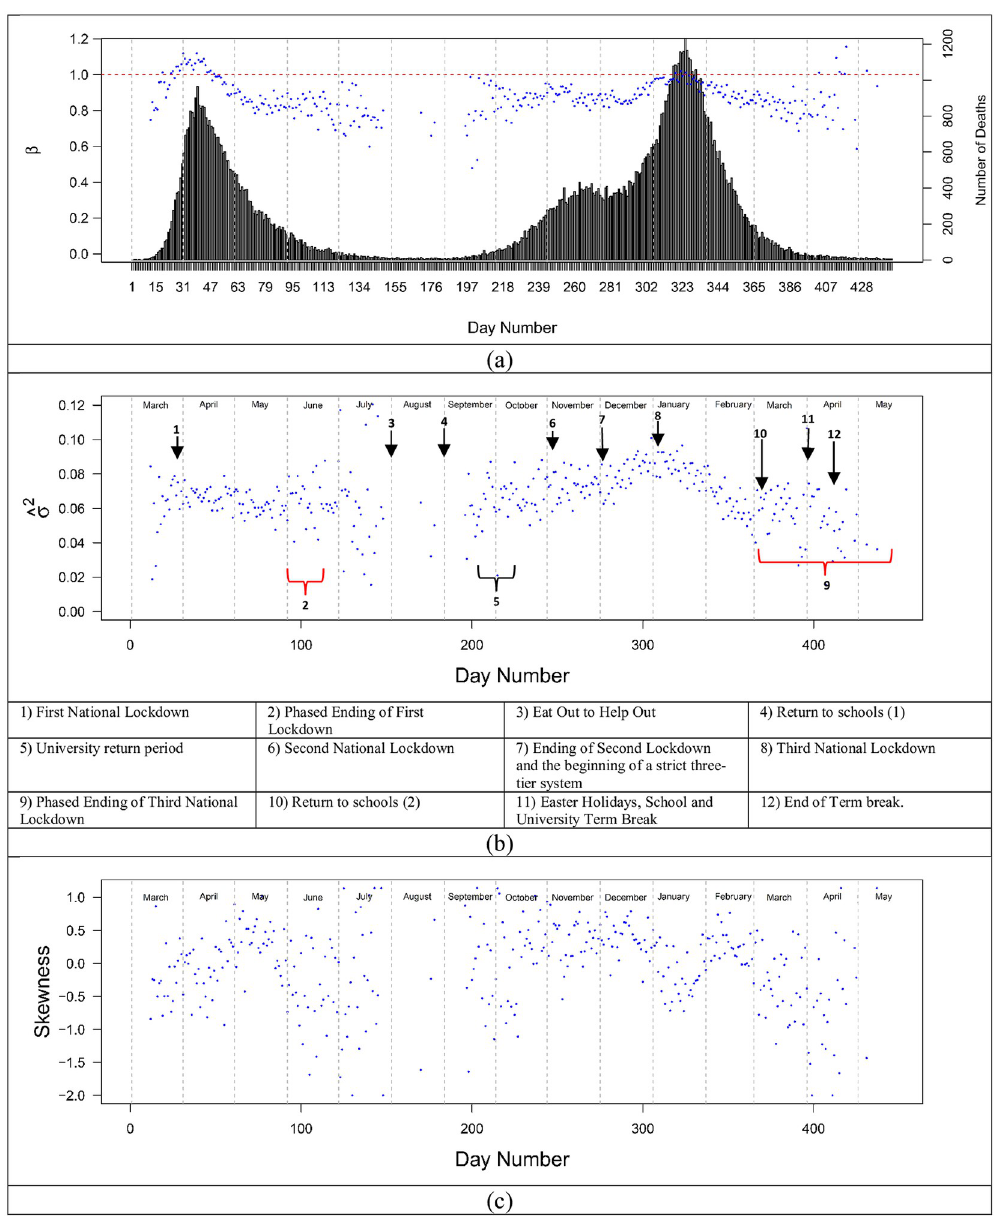
Fig 5. Daily time series of scaling exponent and residual variance and skewness for deaths 01/03/2020 and 11/01/2021. (a) Time series of daily scaling exponent of COVID-19 deaths, (b) residual variance, and (c) residual skewness. The horizontal line in (a) indicates linear scaling. The bar chart indicates raw daily deaths. Arrows in (b) indicate key dates/time periods and red curly brackets represent phased endings to lockdowns. The second lockdown in Wales preceded England beginning on